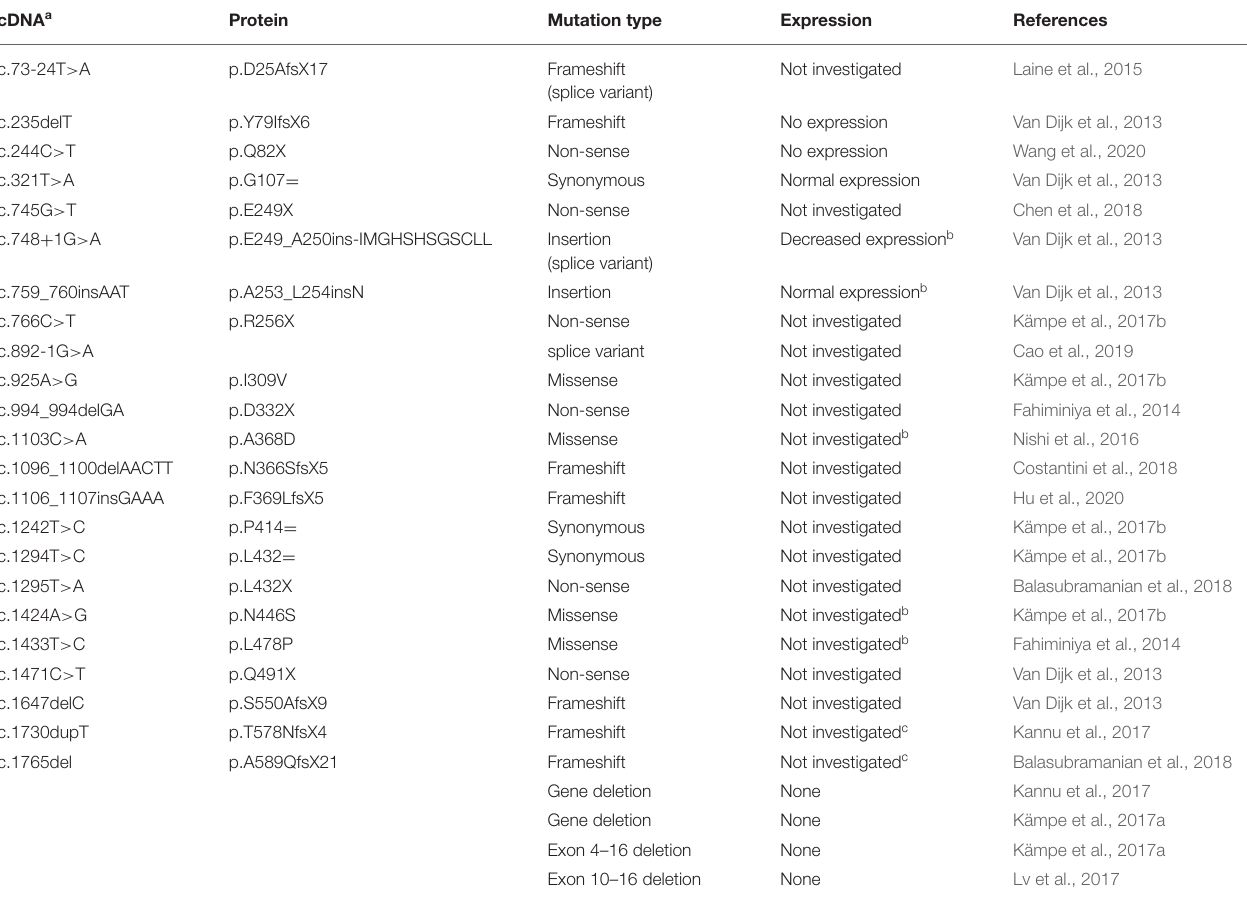
TABLE 1 | List of identified OI-linked PLS3